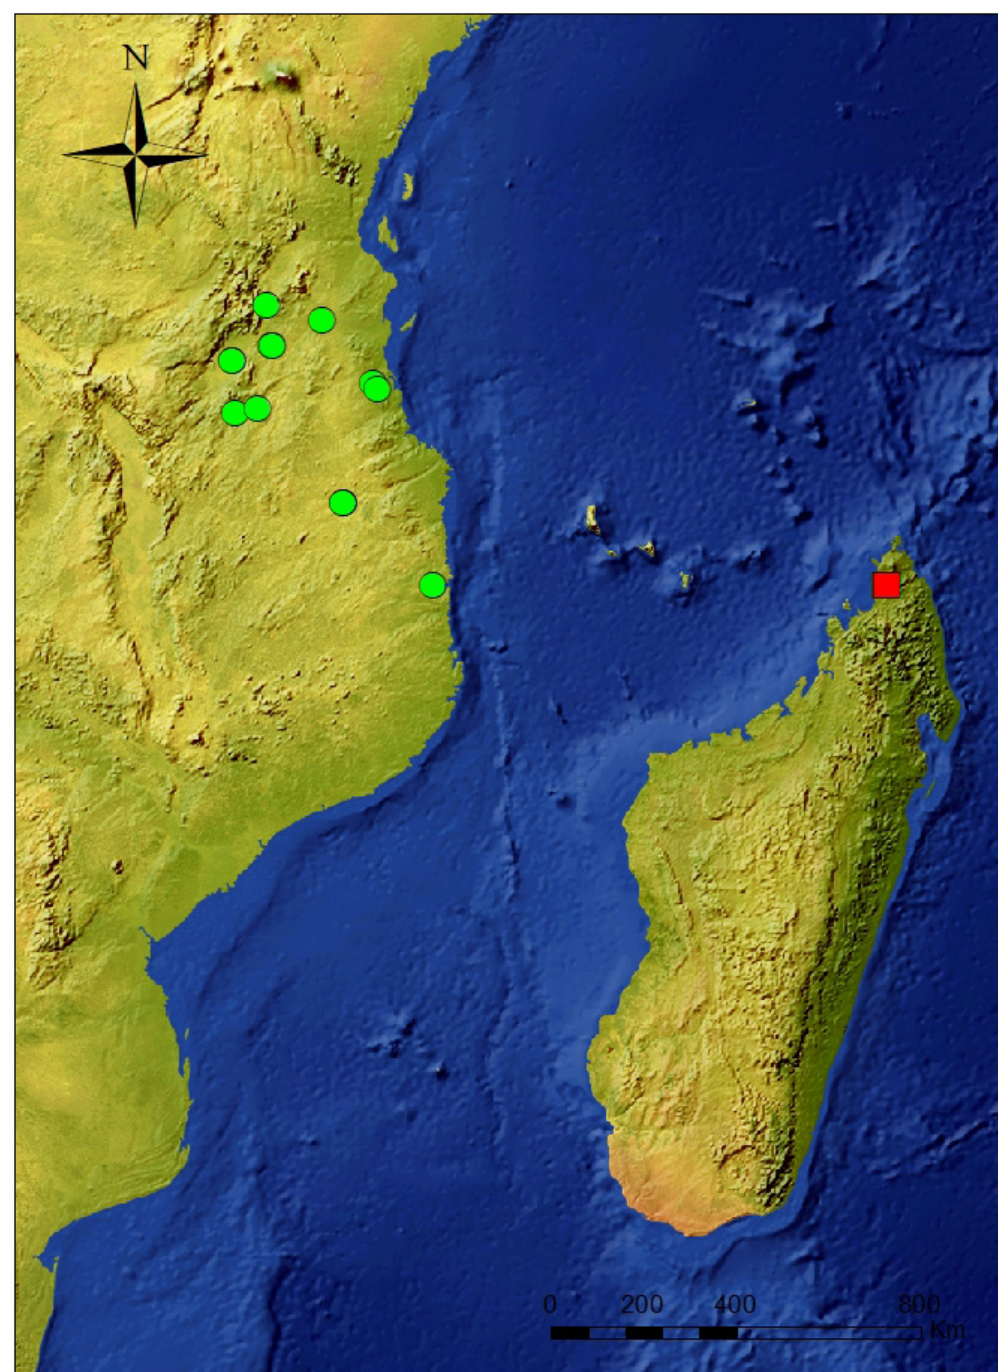
Fig. 2. Distribution of the genus Paranecepsia Radcl.-Sm. in east Africa and Madagascar. Paranecepsia alchorneifolia Radcl.-Sm. (circles), Paranecepsia andrafiabensis Barberá & O.Lachenaud sp. nov.